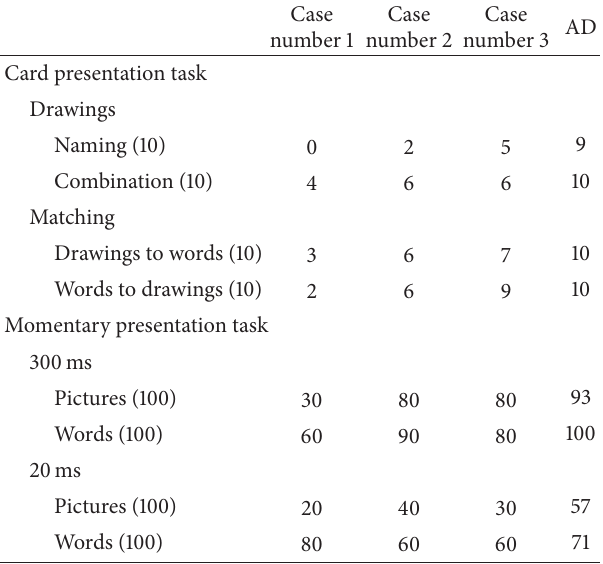
Table 3: Results on semantic memory